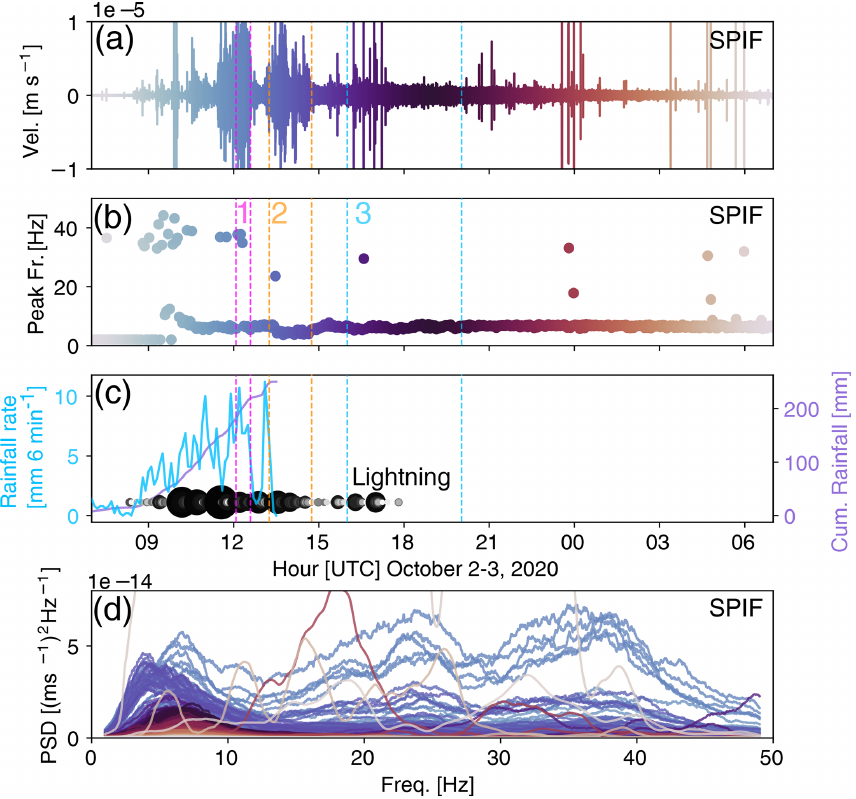
Figure B6. Analysis of seismic data recorded at the SPIF station and meteorological data. (a) Vertical ground velocity recorded filtered in 1– 50Hz. (b) Peak frequency calculated for each 200s segment. (c) Rainfall measured by the rain gauge located at Saint-Martin-Vésubie. This is the closest rain gauge to the SPIF station located at a distance of 1.9km. The measurement stopped when the instrument was destroyed. Lightning at a distance < 15km from the SPIF station. Each circle represents a lightning strike; the larger and the darker the circle, the closer the lightning. (d) Seismic power calculated in windows of 200s. The peak frequency, corresponding time segment, and seismic power (PSD) are marked in the same